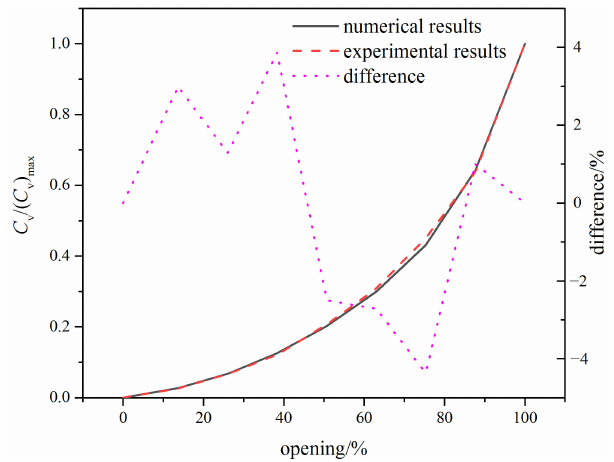
Figure 4. Comparison between the experimental results and the numerical